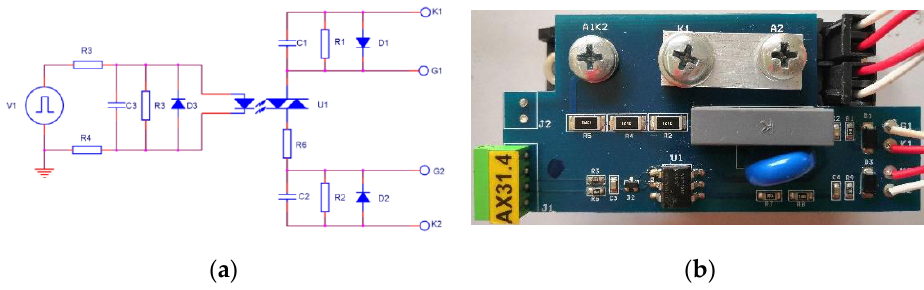
Figure 12. Typical circuit used for SCR drive with opto-isolator. ( a ) schematic circuit diagram ( b ) the practical realization.